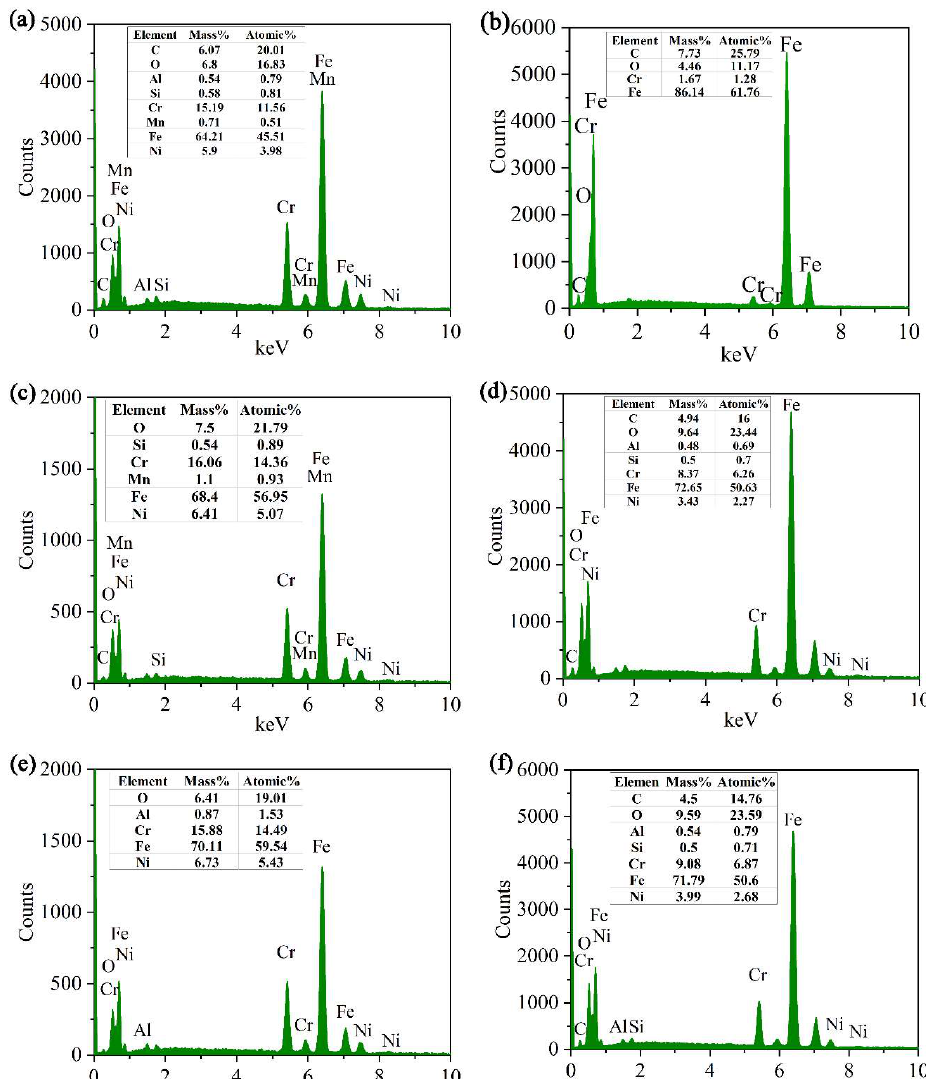
Figure 16. Comparison of EDS spectra of samples used at the rotation radius of 15 mm in the experiment: ( a ) untextured plate; ( b ) untextured ball; ( c ) electric-spark-textured plate; ( d ) electric- spark-textured ball; ( e ) femtosecond-textured plate; ( f ) femtosecond-textured